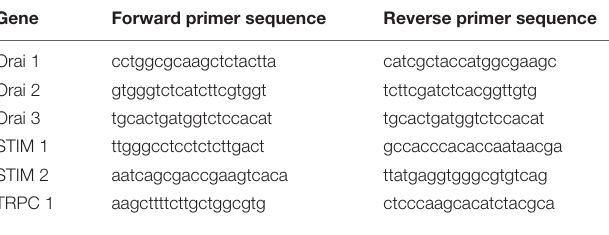
TABLE 1 | List of the primer sequences used for the quantitative